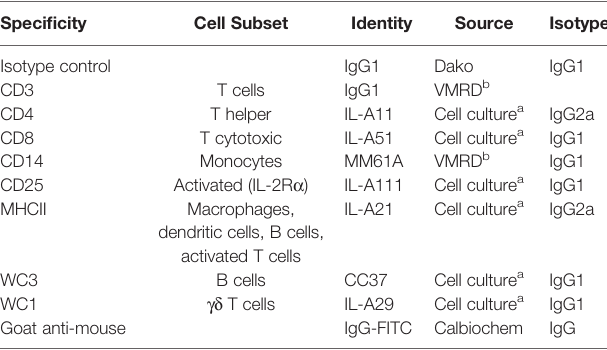
TABLE 1 | Monoclonal antibodies used and the cell subsets labelled in fl ow cytometric analysis of cellular subsets. Speci fi city